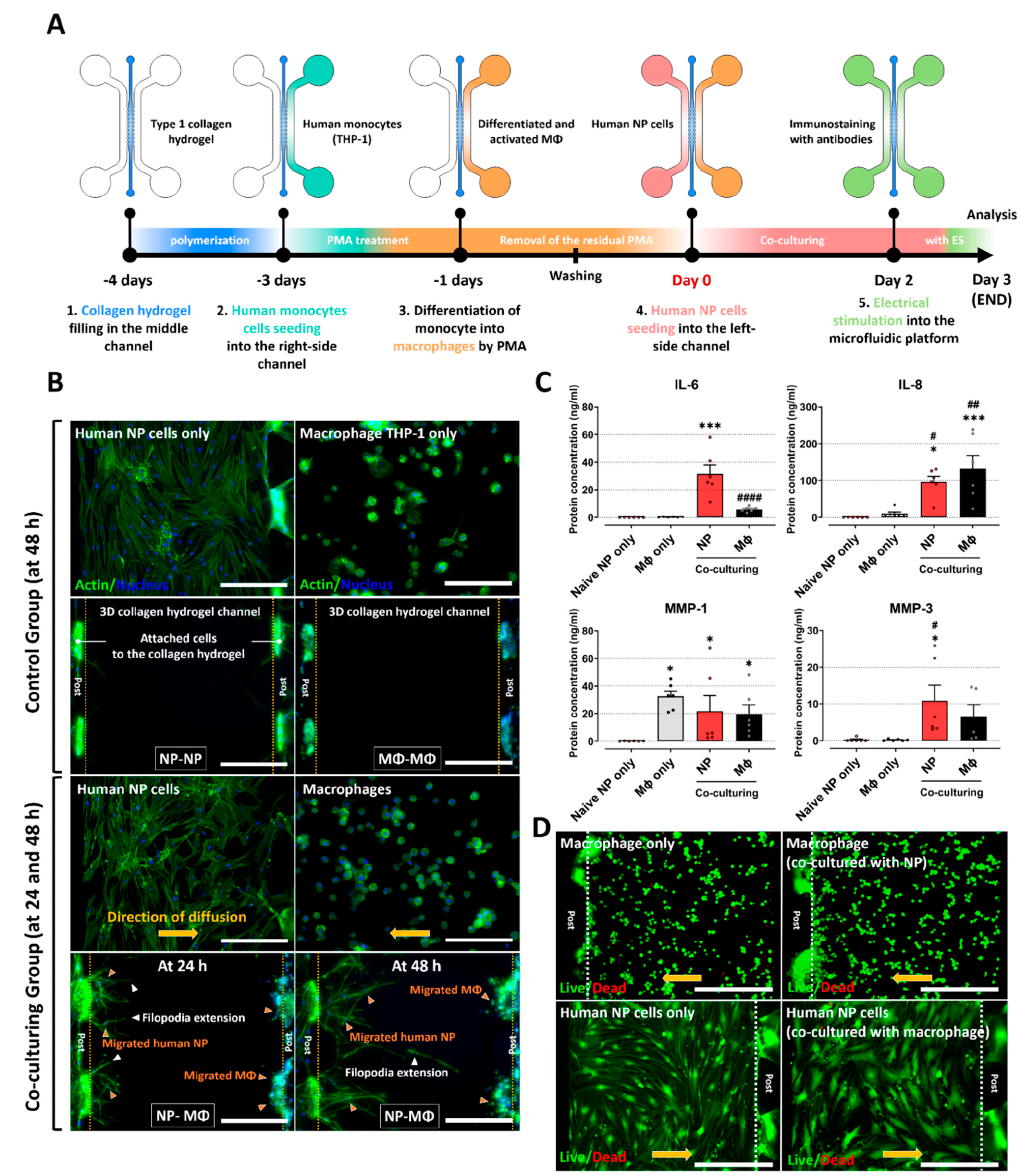
Figure 2. Interaction between human NP cells and macrophage THP-1 cells on the microfluidic plat- form. ( A ) Schematic of experimental setup and timeline on the microfluidic platform. ( B ) Significant migration of human NP cells and macrophage THP − 1 cells (NP − M Φ group) is observed in the central collagen hydrogel channels at culture times of 24 and 48 h (orange arrowhead), whereas the control groups (NP − NP or M Φ − M Φ ) did not exhibit any difference in the migration properties at a culture time of 48 h. In addition, the human NP cells show directional extension of filopodia (white arrowhead), which are the leading edge of lamellipodia in migrating cells, from human NP cells toward the macrophage channel (scale bar = 400 µ m). ( C ) Protein production in human NP cells and macrophages on the microfluidic platform. The coculturing groups show higher protein production due to inflammatory mediators and ECM-modifying enzymes than naïve NP cells or naïve macrophages. ( D ) Assessment of human NP or macrophage cytotoxicity on the microfluidic platform using a live/dead assay. Both human NP cells and macrophages did not show any difference in cell cytotoxicity compared with naïve NP cells or naïve macrophages (scale bar = 400 µ m). * p < 0.05, and *** p < 0.001 as compared to naïve NP cells. # p < 0.05, ## p < 0.01, and #### p < 0.0001 as compared to naïve macrophages. Each dot represents the mean of six samples in an independent